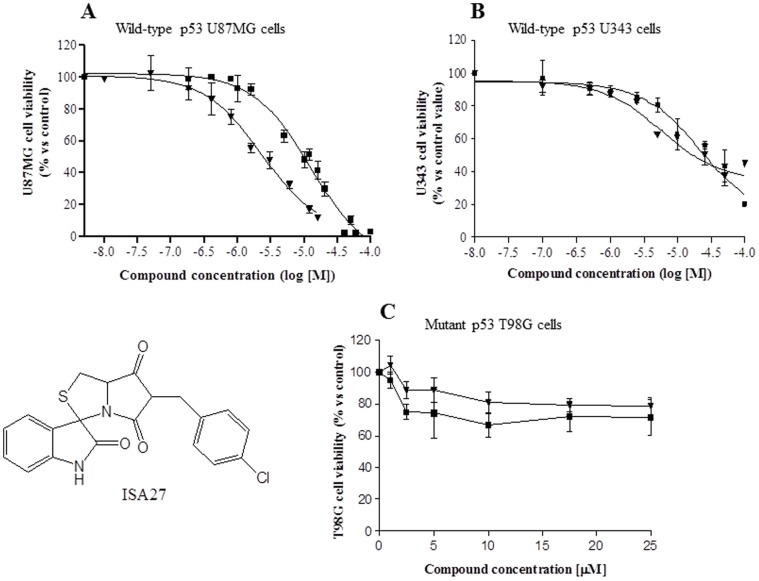
ISA27 inhibits the growth/survival of GBM cell lines expressing wild-type p53.GBM cells with wild-type p53 (U87MG, U343MG) were exposed to a range of ISA27 or Nutlin-3 concentrations for 24 h. After incubation, GBM cell viability was determined by MTS assay. A and B) Effect of ISA27 on the growth/survival of GBM cell lines expressing wild-type p53: curves for U87MG and U343MG cell samples were generated using a sigmoidal dose-response curve model (GraphPad Prism 4 software) from which the IC50 values were derived. ISA27-treated cells (▾), Nutlin-3-treated cells (▪); C) Effect of ISA27 on the growth/survival of the GBM T98G cell line expressing mutant p53: T98G cells were incubated with increasing concentrations of ISA27 or Nutlin-3 (ranging from 1 µM to 25 µM), and cell viability was measured after 24 h by MTS assay. ISA27-treated cells (▾), Nutlin-3-treated cells (▪). The results are expressed as the percentages of cell viability with respect to the vehicle-treated sample for each cell line; the viability of the vehicle-treated sample was arbitrarily set at 100%. Points, means of three independent experiments performed in duplicate; bars, SEM.